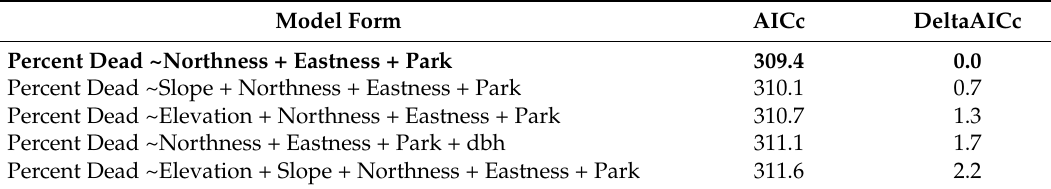
Table 3. Top five linear mixed effect models for predicting percent dead trees; the selected model is in bold . All models contain a random site effect. DeltaAICc is the difference in AICc from the top model. Model Form AICc DeltaAICc Percent Dead ~Northness + Eastness + Park